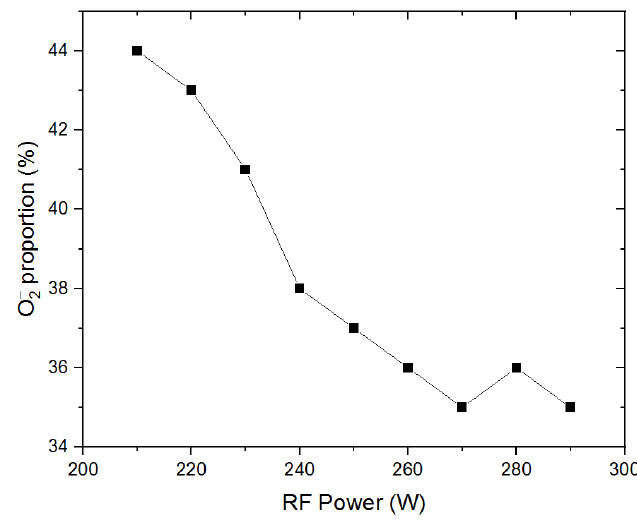
− in total extracted ion beam vs. RF 2